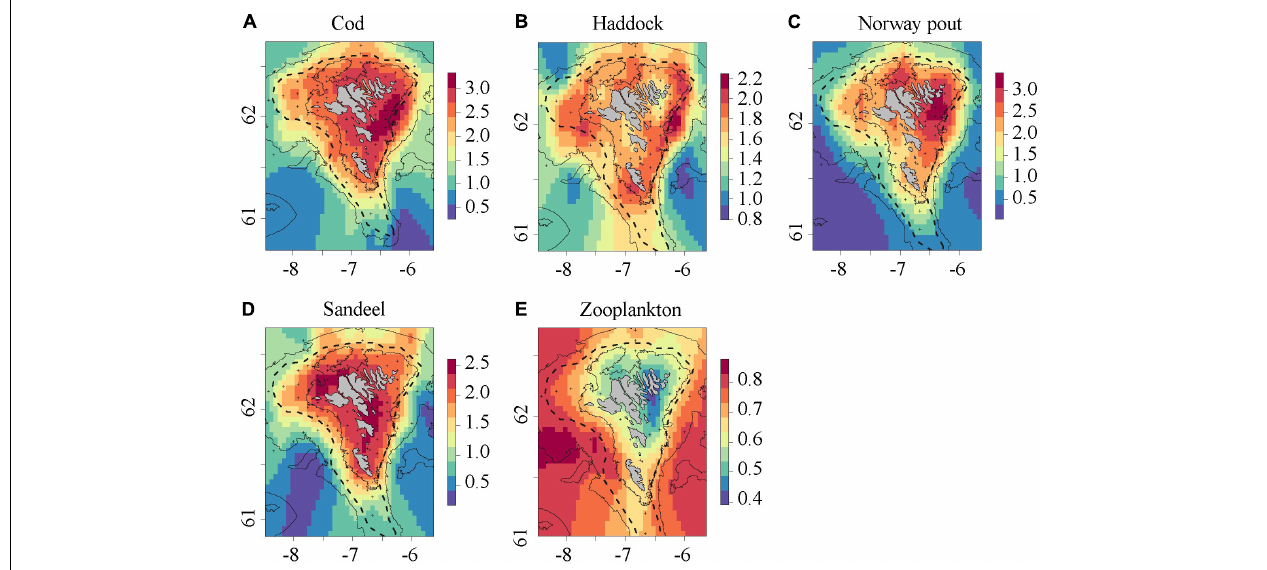
FIGURE 2 | Log-transformed distribution of (A) cod, (B) haddock, (C) Norway pout, (D) sandeel (1993–2018), and (E) zooplankton biomass on the Faroe shelf (1989–2018). The data were smoothed with a kernel bandwidth of 0.1 ◦ . Black (+) indicate sampled stations, gray lines the 100 and 200 m bottom depth contours and the dashed line indicates the average position of the shelf